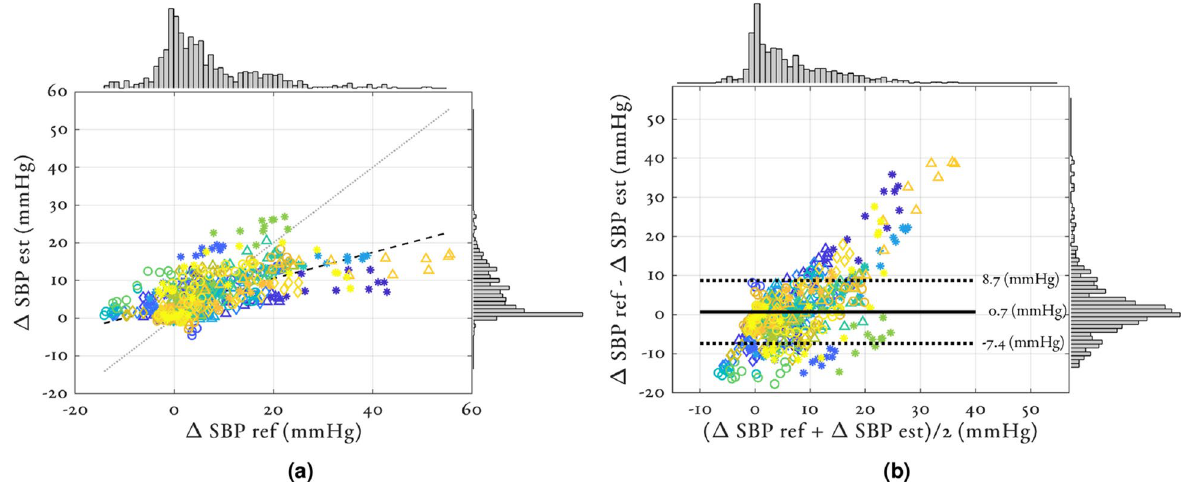
Figure 4. Agreement between the reference (cid:31) SBP values from the sphygmomanometer cuff and the estimated (cid:31) SBP using RF PPG + ECG . Individual participants are colour and marker-coded. ( a ) The correlation analysis, the overall correlation was 0.64, the median participant-wise correlation coefficient was 0.86 with a range of 0.34 to 0.95. Black striped line shows regression line. Grey dotted line shows line of unity. ( b ) The Bland-Altman analysis, the bias of the overall error was 0.3 mmHg with a standard deviation of 8.05